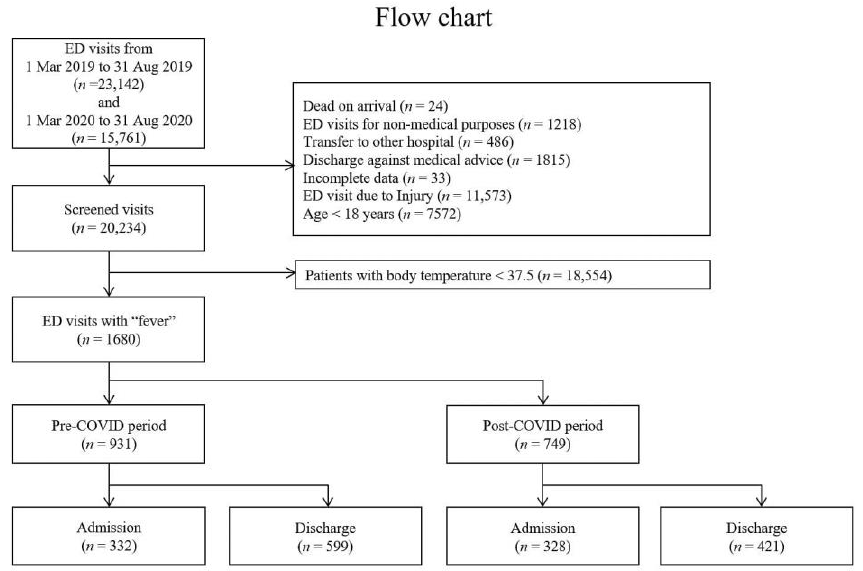
Figure 1. Study design and patient enrollment.